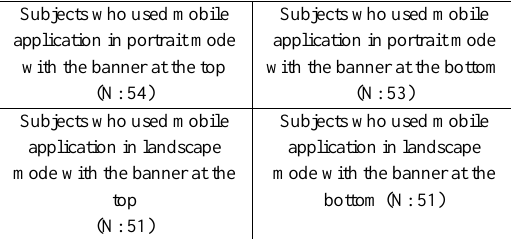
Table 1: The Characteristics of Experiment Groups Subjects who used mobile